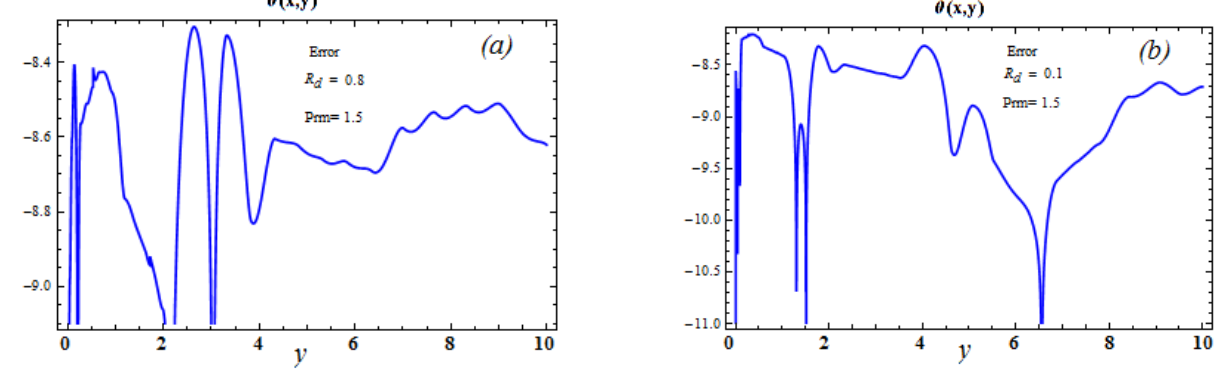
Figure 4. Temperature error analysis for physical parameters ( a ) R d = 0.8 and ( b ) R d = 0.1.